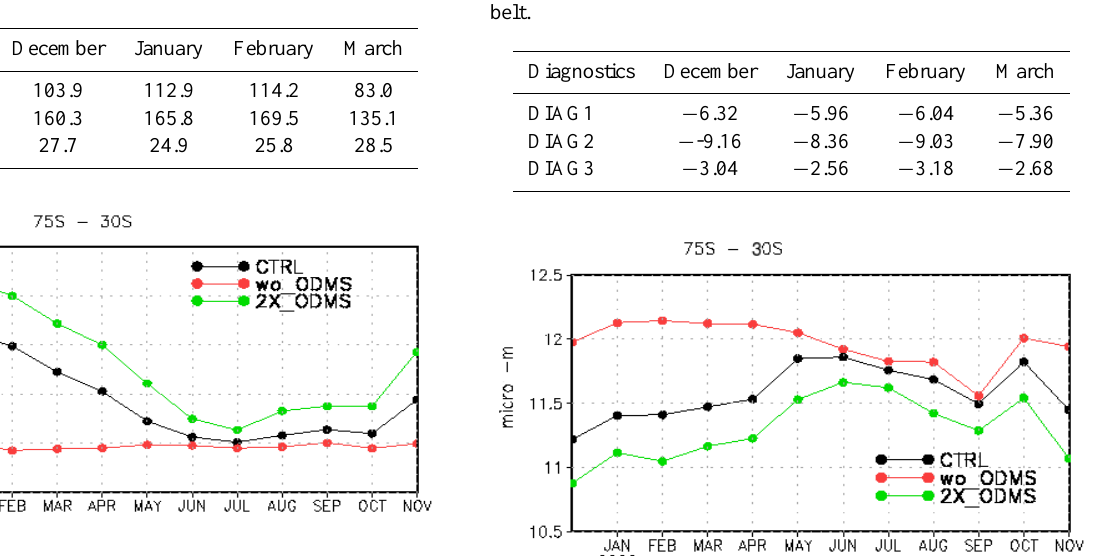
Table 2. Percentage mean change in DIAG1, DIAG2, DIAG3 for zonally averaged CDNC burden over 30S-75S latitudinal belt.